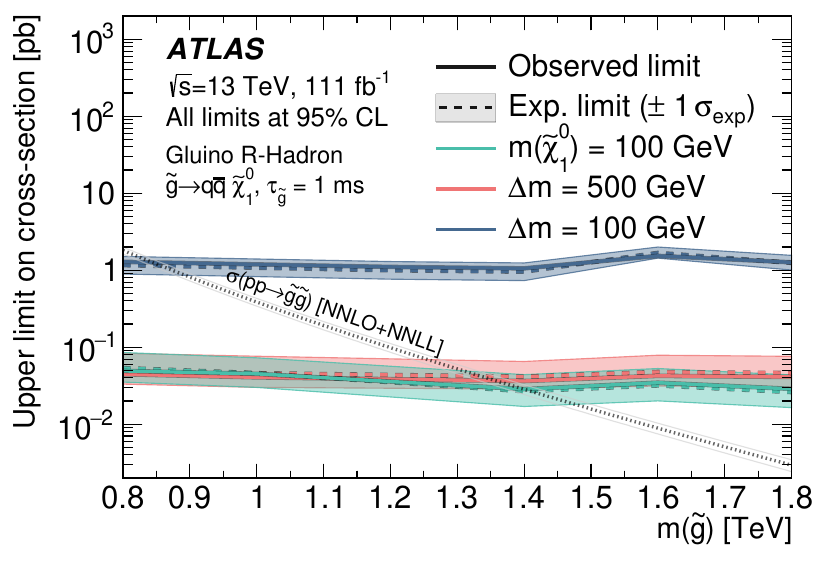
Figure 10 . Expected (dashed lines) and observed (solid lines) signal cross-section exclusion limits at 95% CL using the 2017 and 2018 datasets in the central signal regions. The cross-section limits are shown as a function of gluino mass. The shaded coloured bands represent the ± 1 σ variations from systematic and statistical uncertainties in the expected yields. The different sets of colours represent the limits for different assumptions about the gluino-neutralino mass splitting. The grey dotted line and band represent the NNLO+NNLL theory prediction and uncertainties in the production cross-section,